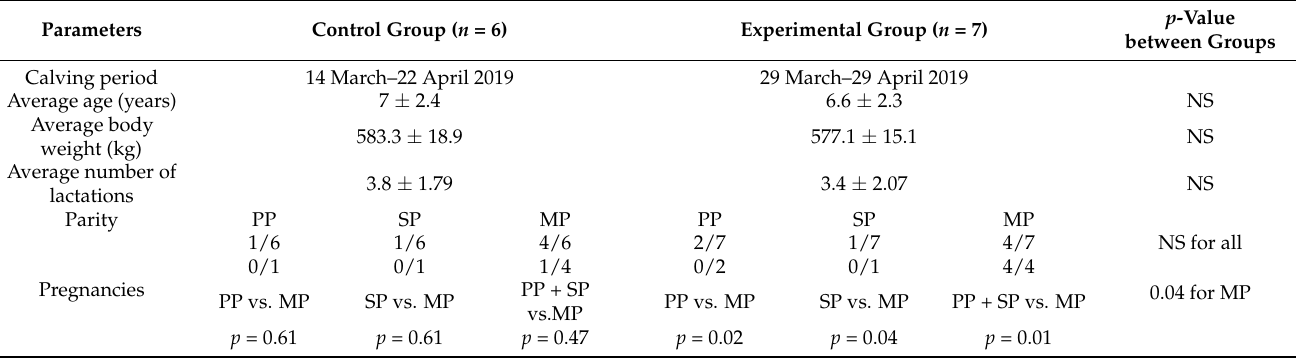
Table 6. Comparative analysis of the biometric parameters and established pregnancies between the control and experimen- tal